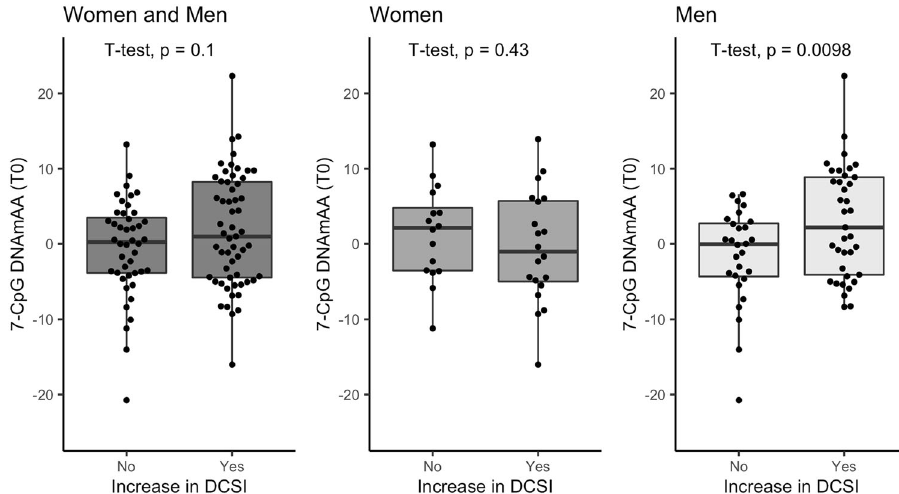
Fig. 2 Boxplot of 7-CpG DNAmAA at baseline strati fi ed by increase in DCSI during follow-up period. Analyses were performed on all participants and in sex-strati fi ed subgroups. Median, hinges (25th and 75th percentile) and Tukey-style whiskers (1.5* inter-quartile-range) are displayed. Women and Men: n = 101; Women: n = 36; Men: n = 65. Note: CpG = Cytosine phosphate guanine, DNAmAA = DNA methylation age acceleration, DCSI = Diabetes Complications Severity Index. Table 5 Logistic regression of increase in DCSI of one or more points vs. no increase in DCSI (dichotomized) between baseline and follow-up on 7-CpG DNAmAA at baseline and covariates.